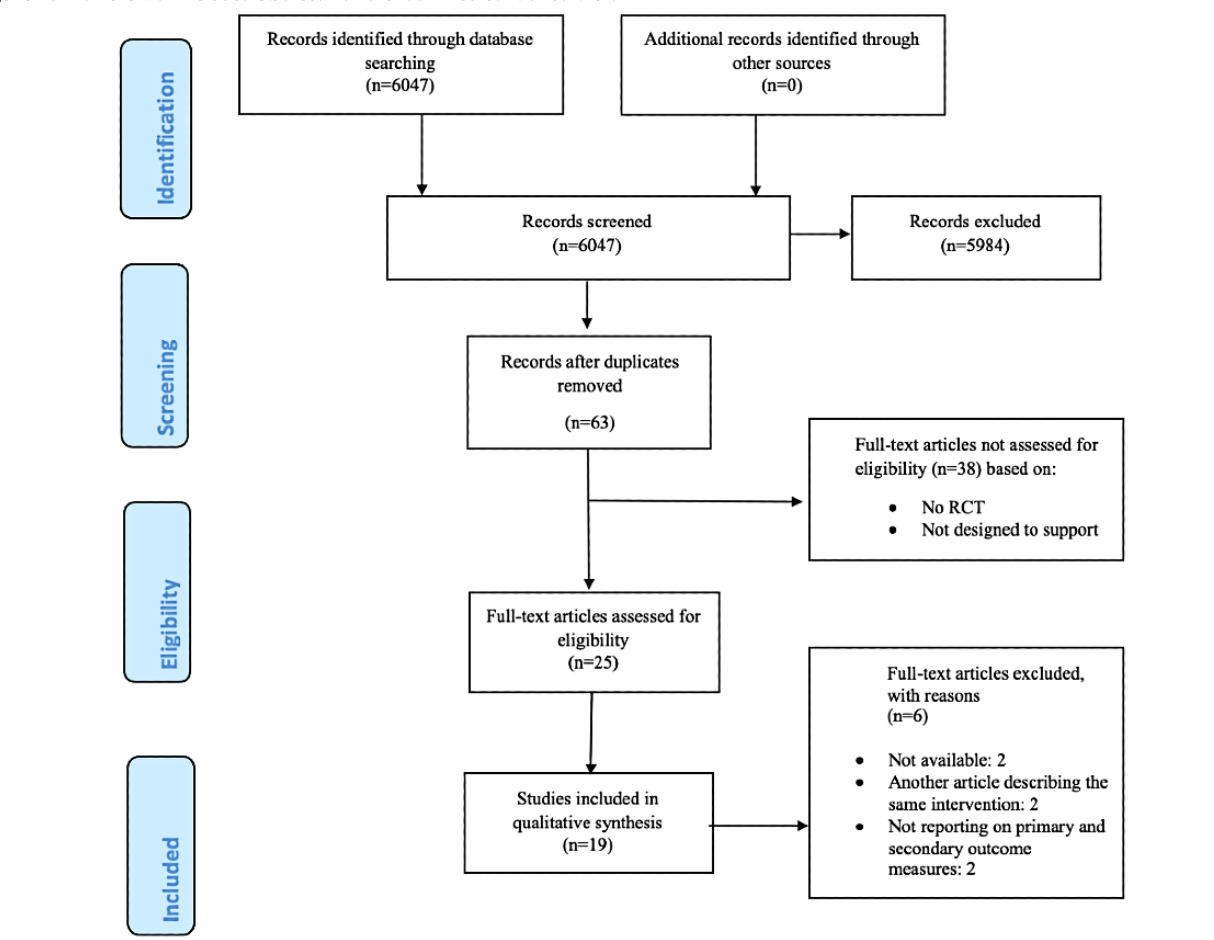
Figure 1. Flowchart of included studies. RCT: randomized controlled